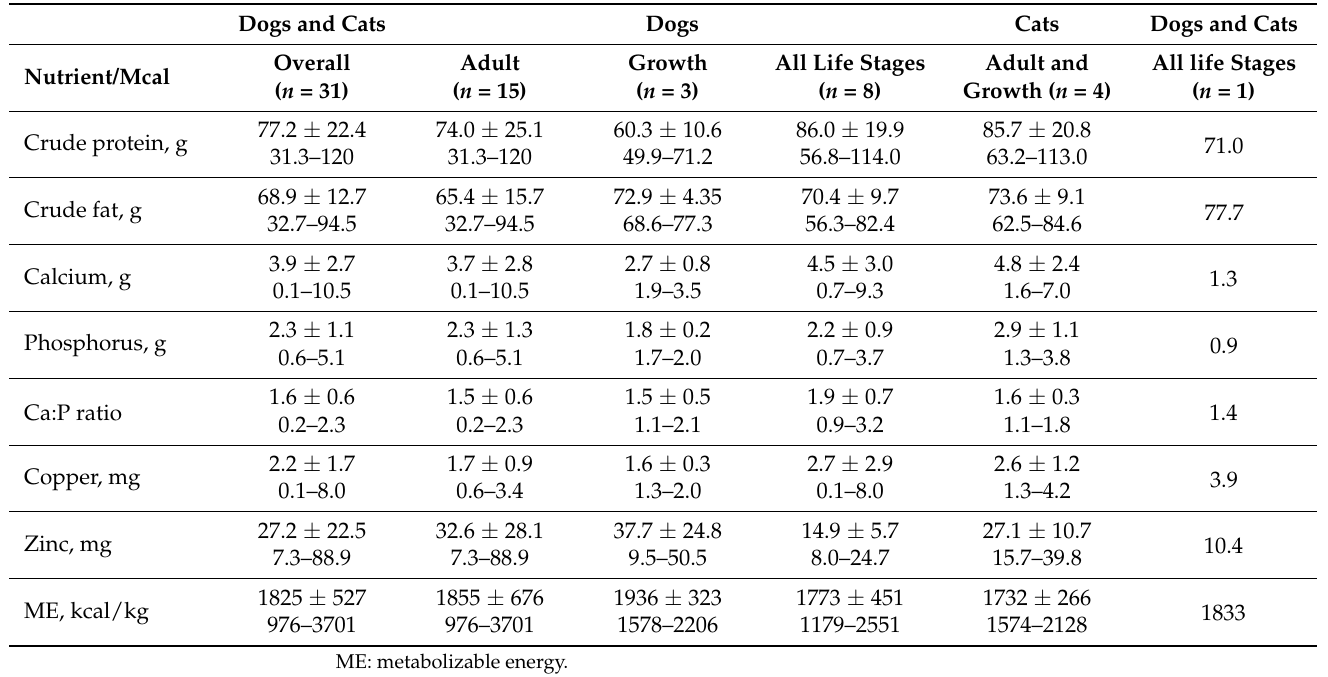
Table 4. Macronutrient, selected minerals and energy content [mean ± SD; range (min-max)] of 31 RMBDs labelled as complete pet food.